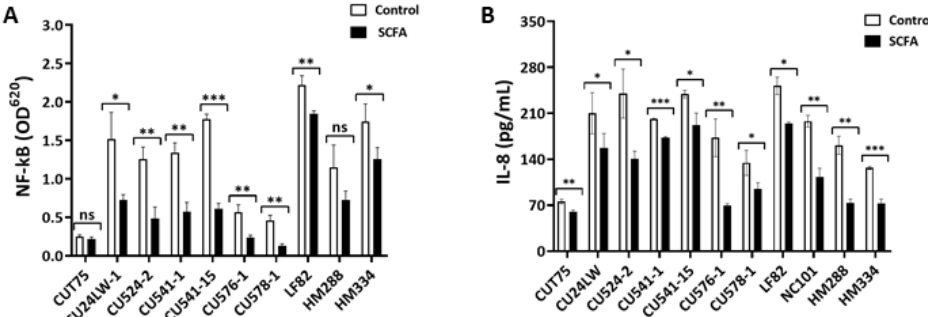
Figure 8. c-SCFA inhibit NF- κ B pathway activation and IL-8 production in the host cells. ( A ). Hek-Blue cells were infected with E. coli in the presence of 123 mM NaCl or SCFA at pH 6.5 (see Methods). At 24 h post infection, the supernatant of the infected cells was used to detect the reporter protein (secreted alkaline phosphatase, SEAP) production. ( B ). Caco-2 cells were infected by E. coli for 3 h in the presence of either NaCl or c-SCFA (65 mM) at pH = 6.5. The supernatant of infected Caco-2 cells was used for IL-8 detection using ELISA method. Data from three independent experiments; Mean ± SE. * p < 0.05; ** p < 0.01; *** p < 0.001; ns = not significant.